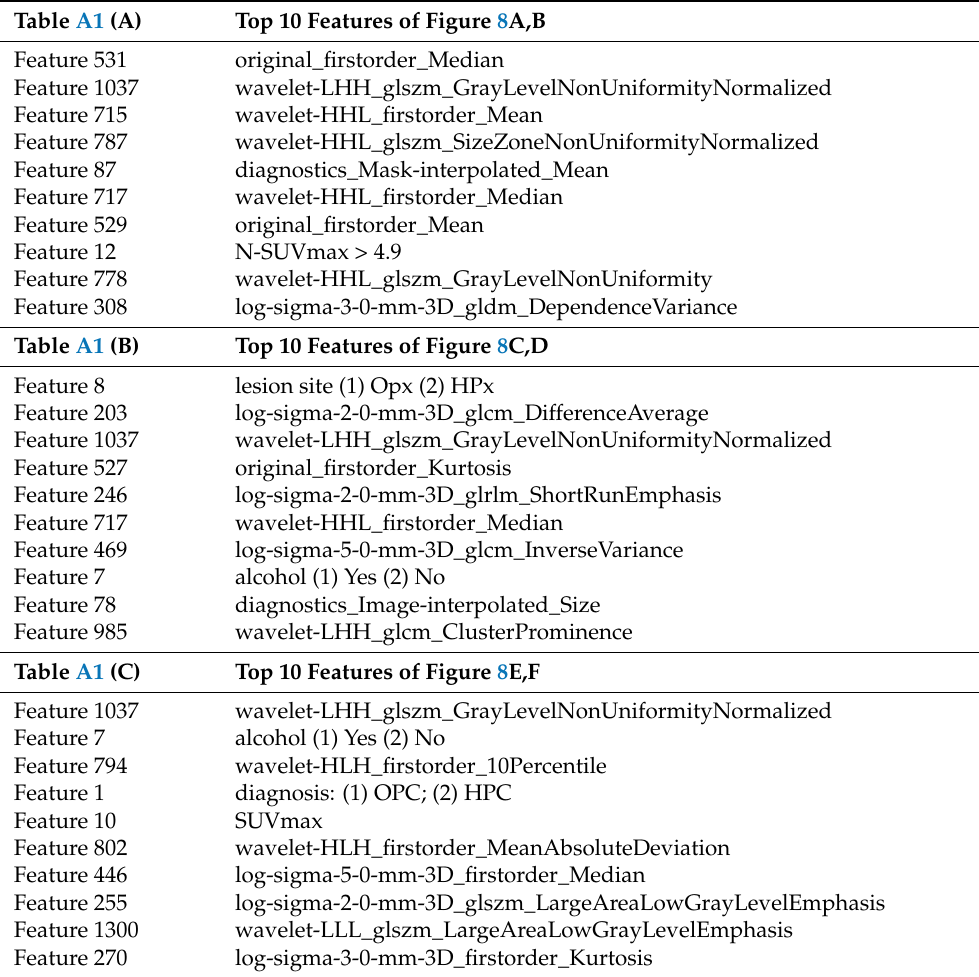
Table A1. Top 10 Features of Figure 8. Table A1 (A) Top 10 Features of Figure 8A,B